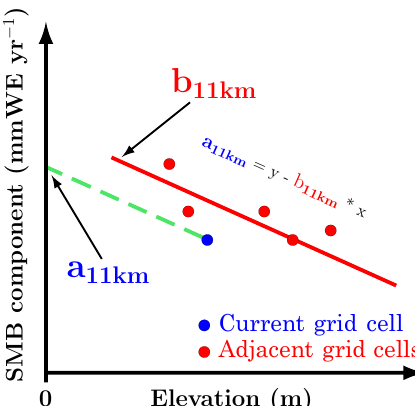
Figure 4. Elevation-dependent downscaling procedure: b 11km and a 11km are respectively the daily local estimates of the SMB com- ponents regression to elevation and the SMB components value at mean sea level obtained on the RACMO2.3 grid at 11km. The red line corresponds to the regression ( b 11km ) calculated using the cur- rent grid cell (blue dot) and the adjacent ones (red dots). The dashed green line applies the regression slope to the current grid cell to es- timate a 11km .